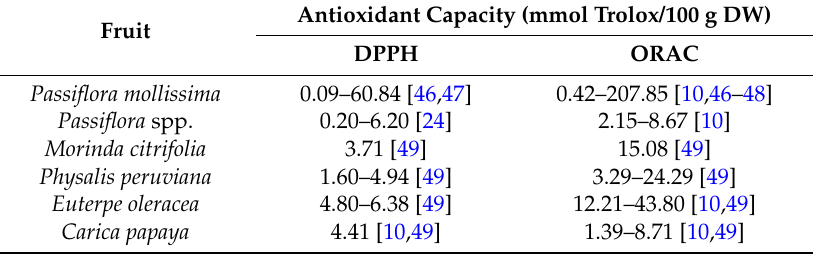
Table 5. Antioxidant capacity: Passiflora spp. and other Latin American fruits.